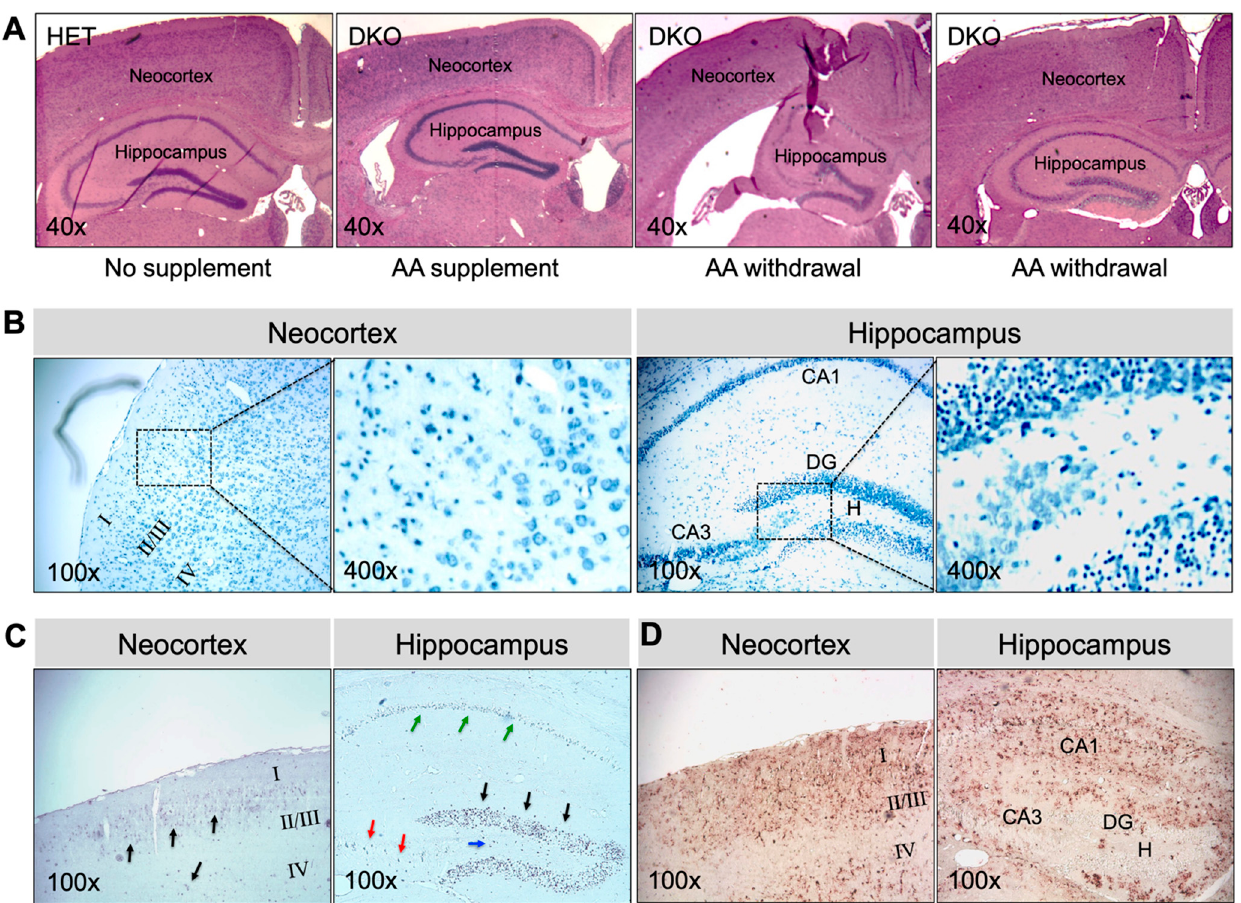
Figure 5. Brain pathology in AA-rescued DKO mice at 17–20 days after AA removal. ( A ), Representative images of HE staining of paraffin-embedded brain coronal sections from HET mice, AA-rescued DKO mice kept on AA supplementation, and AA-rescued DKO mice with AA removal (starting at age 1 month or 3 months) for 17–20 days. Representative images of ( B ), TBO staining, ( C ), TUNEL staining, and ( D ), IHC staining for GFAP of paraffin-embedded brain coronal sections from AA-rescued DKO mice with AA removal (starting at age 1 month) for 20 days. In ( B ), the square area in the left panel was enlarged in the right panel. In ( C ), arrows showing TUNEL-positive (apoptotic) cells. HE, hematoxylin and eosin; TBO, toluidine blue O; DG, dentate gyrus; CA1, cornu ammonis-1; CA3, cornu ammonis-3; H, hilus; TUNEL, terminal deoxynucleotidyl-transferase-mediated dUTP nick-end-labeling; IHC, immunohistochemistry; GFAP, α -glial fibrillary acid protein. Magnifications: 40×, 100×, and 400× as indicated.